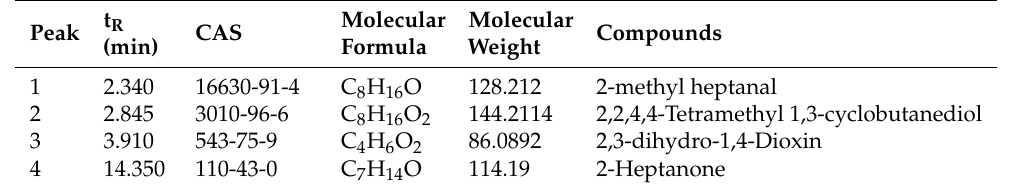
Table 2. Volatile constituents of BS4 tobacco seed oil.